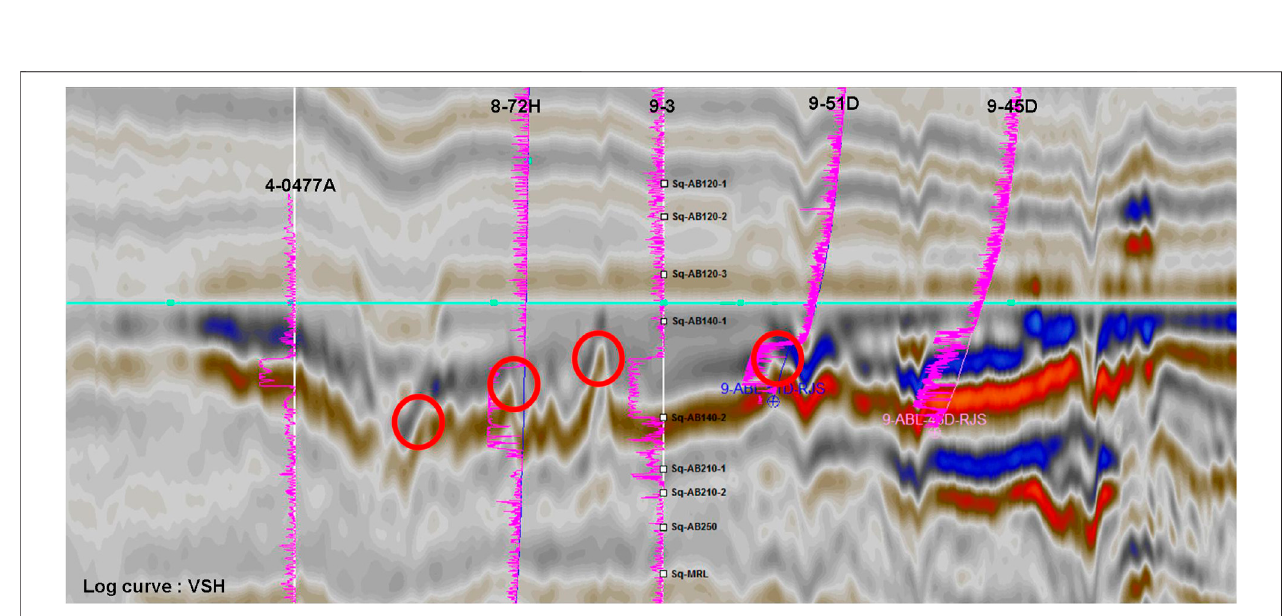
FIGURE 12 | Architecture boundary characteristics of sand bodies with elevation difference in ABL oil fi